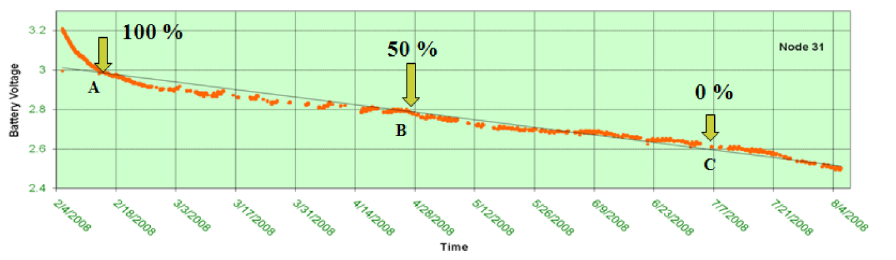
Figure 6. Battery discharge curve of a typical node in Paradisenet